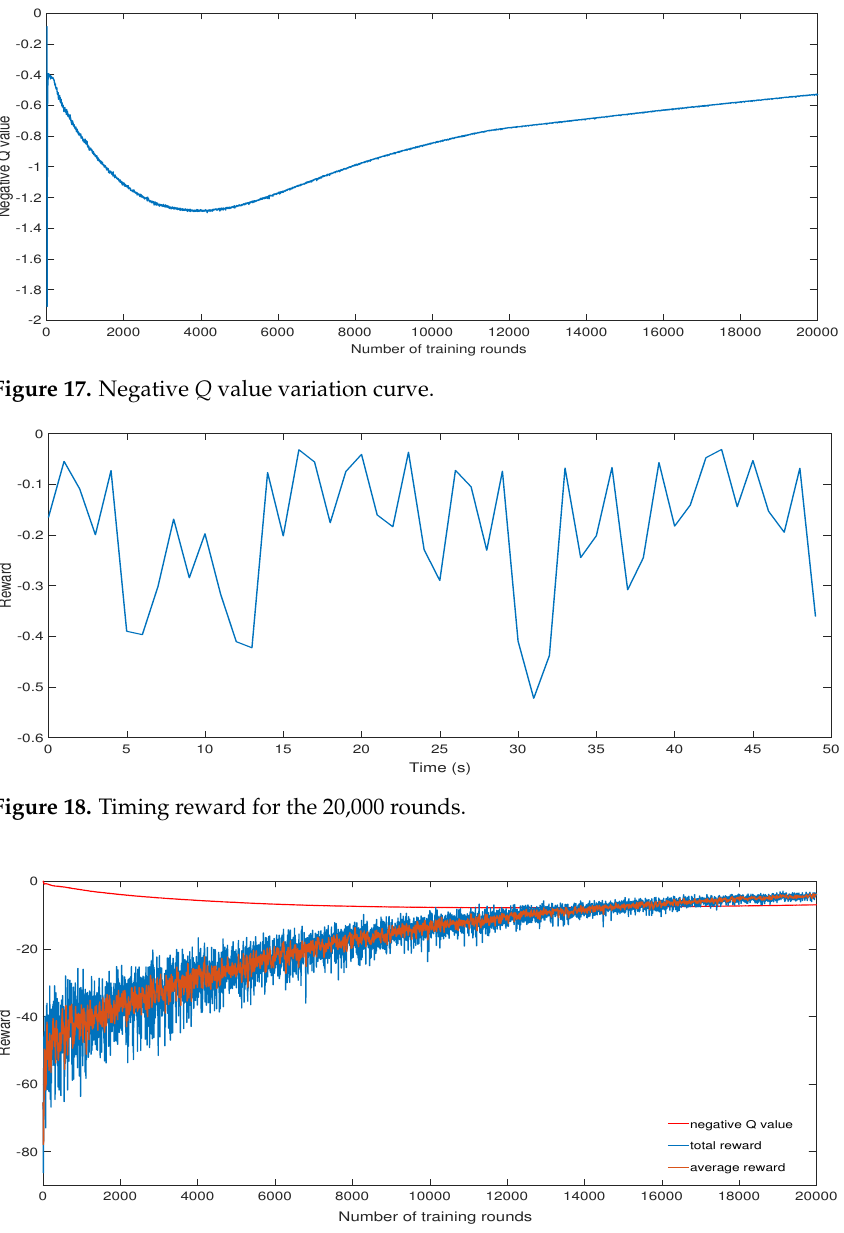
Figure 19. The variation curve of reward value in the presence of